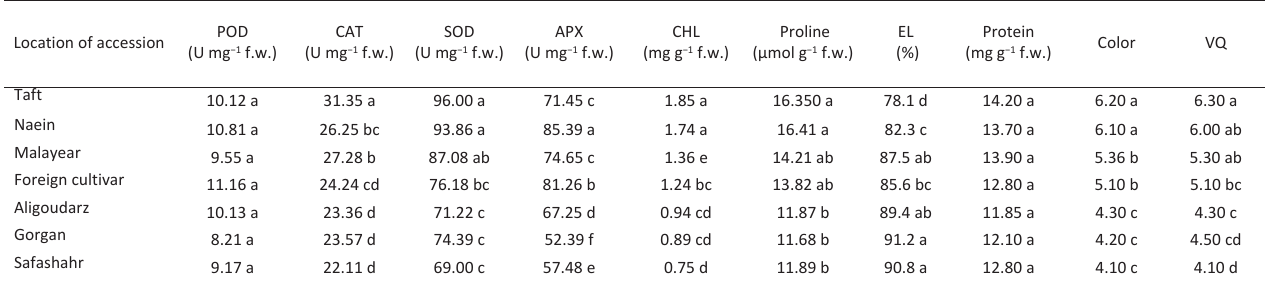
In each column, means with the same letter are not significantly different according to Least Significant Difference (LSD) test at P= 0.05. Turfgrass visual quality and color based on a scale of 1-9, 1= brown/dead turf, 6= minimal acceptable turf, 9= ideal green, healthy turf.